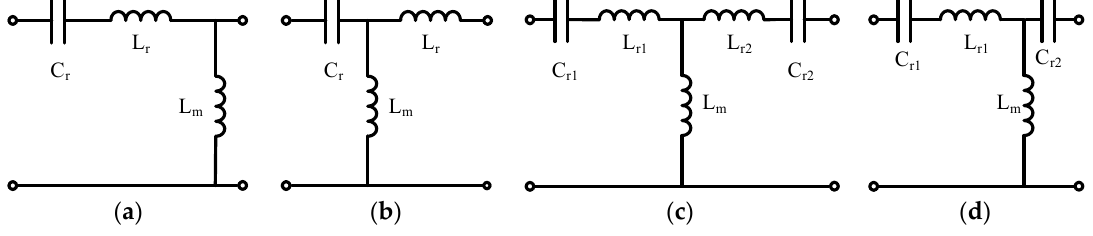
Figure 2. Structures of resonant tanks of different types. ( a ) Type-4, i.e., LLC; ( b ) Type-11; ( c ) CLLLC; ( d ) CLLC.